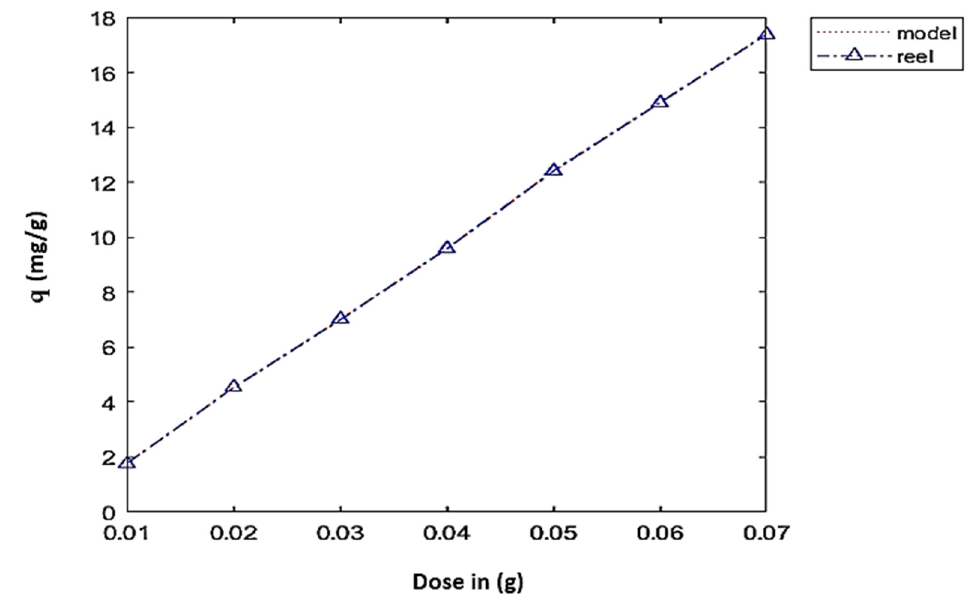
Figure 8. Comparison between the mathematical model and the observed results.